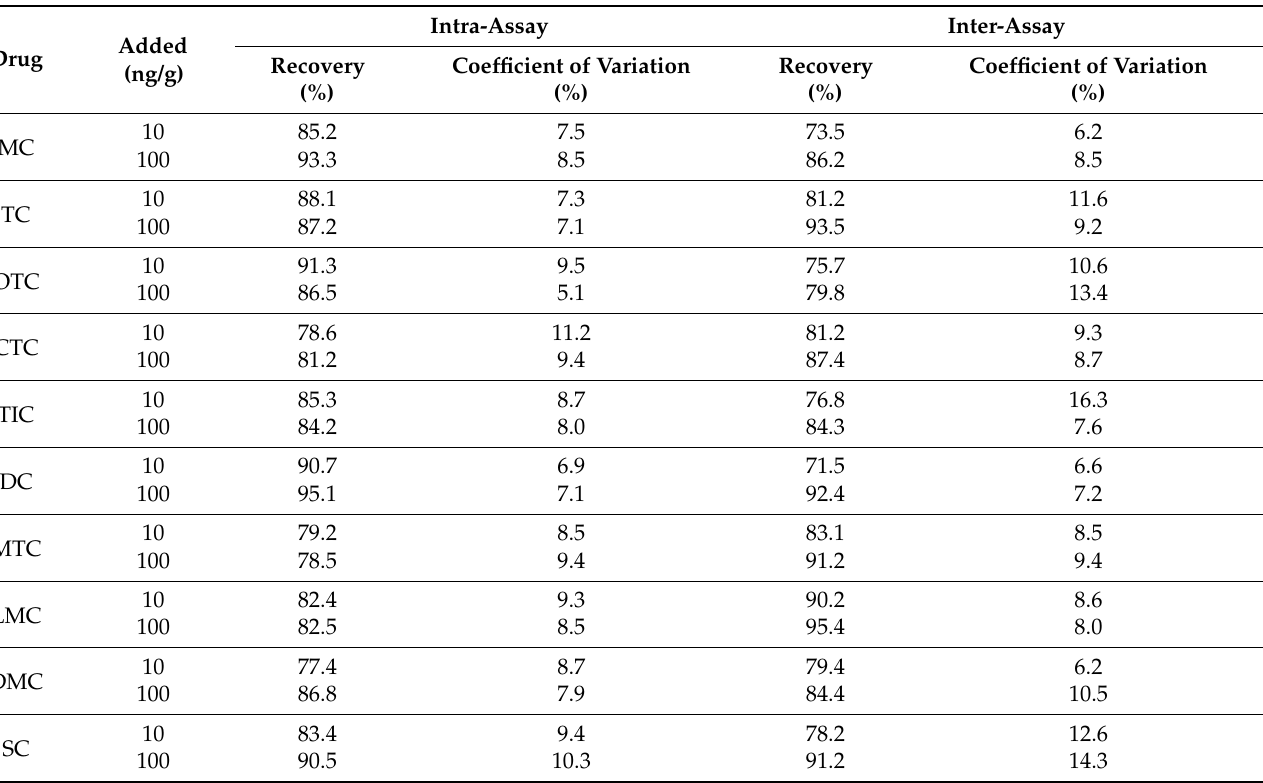
Table 2. Recoveries of the 10 TCs from standard fortified blank milk samples ( n = 6; intra-assay, mean recovery of six repetitions in one day; inter-assay, mean recovery of duplicate analysis on six successive days; coefficient of variation, standard deviation/mean value ×